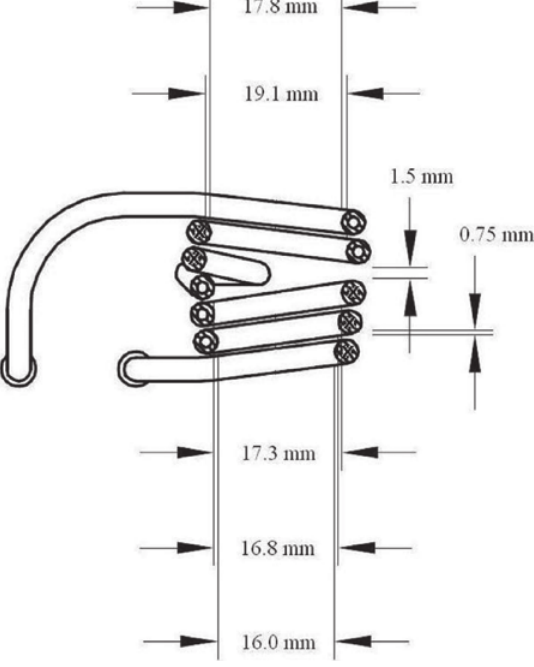
Fig. 2: Schematic diagram of the levitation